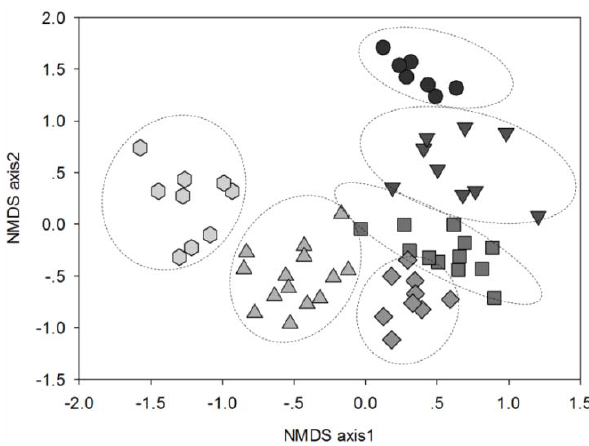
Fig. 1. Non-metric multidimensional scaling (NMDS) ordi- Fig.1. Non-metric multidimensional scaling (NMDS) ordination of the 60 sandy grassland sites (minimum stress nation of the 60 sandy grassland sites (minimum stress val- ues first axis/dimension = 49 . 13, R 2 = 0 . 28, P = 0 . 004; second values first axis/dimension=49.13, R 2 =0.28, P =0.004; second axis/dimension=31.66, R 2 =0.42, P =0.004). , axis/dimension = 31.66, R 2 = 0 . 42, P = 0 . 004). , Mobile Dune; ● ■ N , Semi-fixed Dune; (cid:4) , Fixed Dune; (cid:4) , Dry Meadow; N , Wet Mobile Dune; ▲ , Semi Fixed Dune; ◆ , Fixed Dune; , Dry Meadow; ▼ , Wet Meadow; , Flood Plain 7 • Meadow; , Flood Plain Grassland.